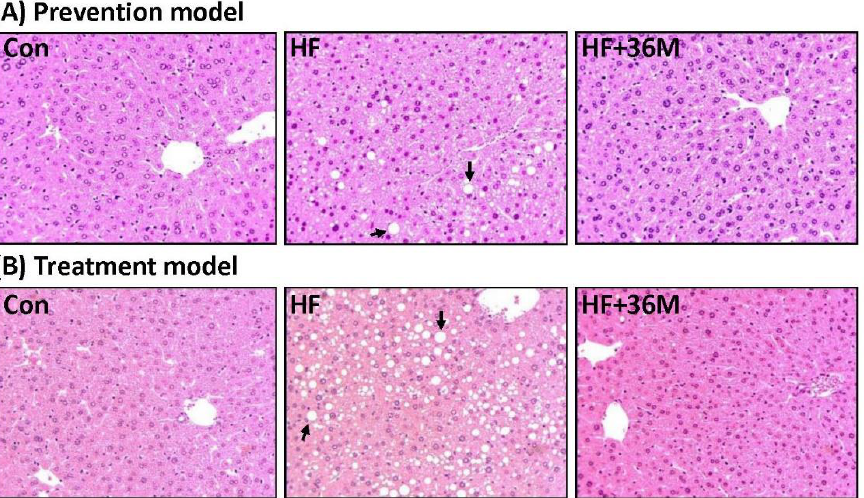
Figure 7. Liver morphology of the mice. ( A ) The representative images for liver hematoxylin and eosin (H&E) staining of the mice in the prevention model. ( B ) The representative images for liver H&E staining of the mice in the treatment. → indicates the representative lipid droplets. Con: control; HF: high-fat diet.